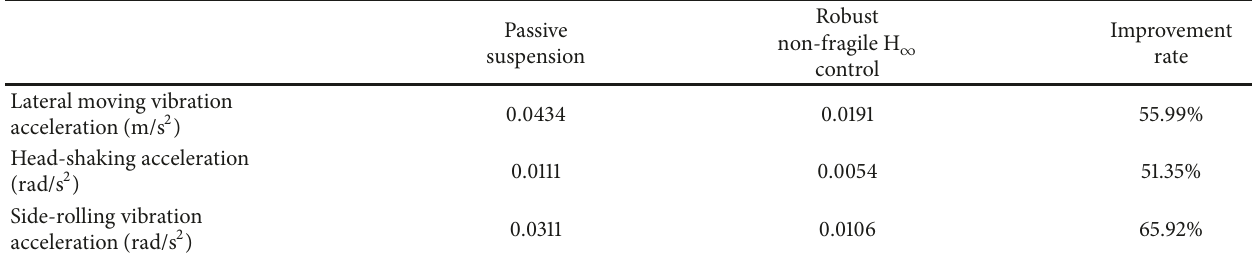
Table 2: Comparison of the maximum acceleration of vehicle body in frequency domain analysis.